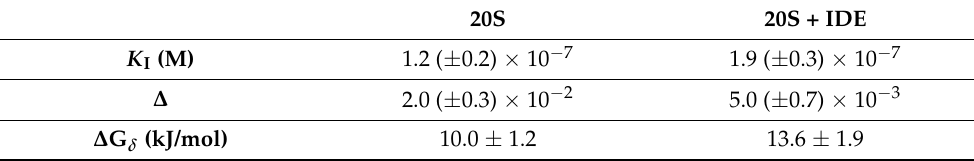
Table 1. Binding parameters of CFZ with 20S proteasome at pH 7.6 and 37 °C.